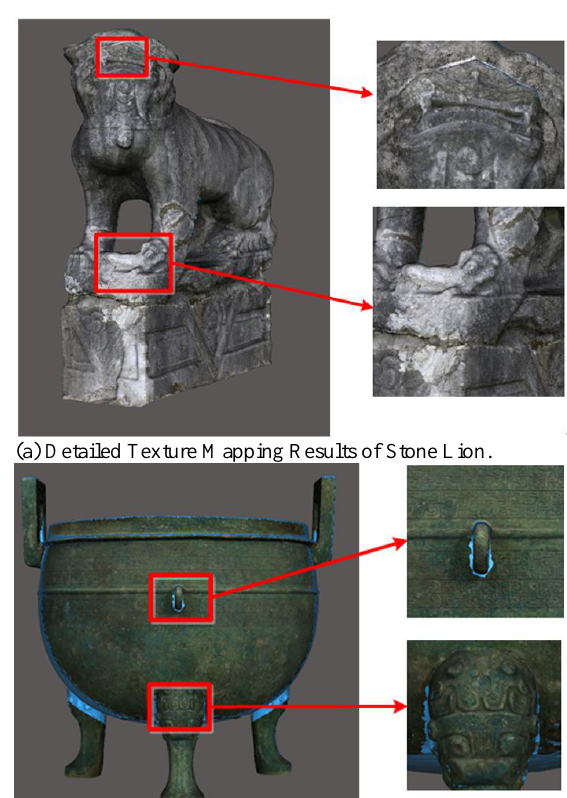
Figure 13: Details ofTexture Mapping Result.